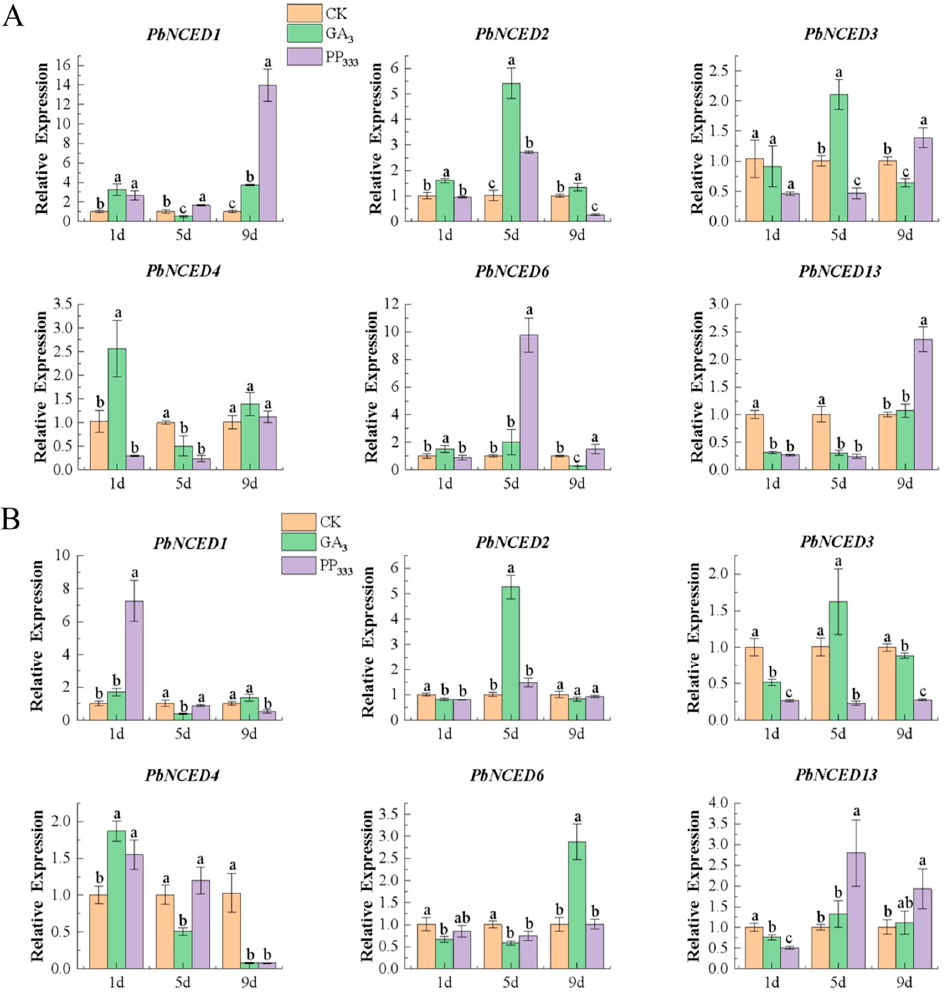
Figure 8. The relative expression levels of the PbNCEDs in sepal ( A ) and ovary ( B ). Different lowercase letters indicate significant differences at the level of p < 0.05 between treatments.